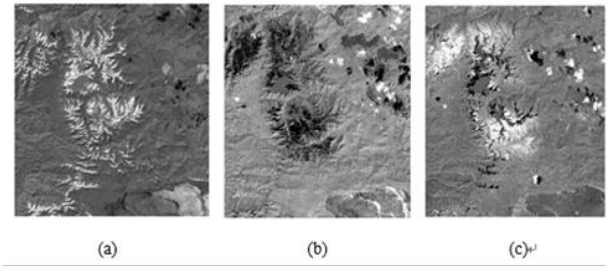
Figure (a) is the differential image between DEM data from 2004 and 2007. Figure (b) is the differential image between DEM data from 2007 and 2011. Figure (c) is the differential image between DEM data from 2011 and 2014.